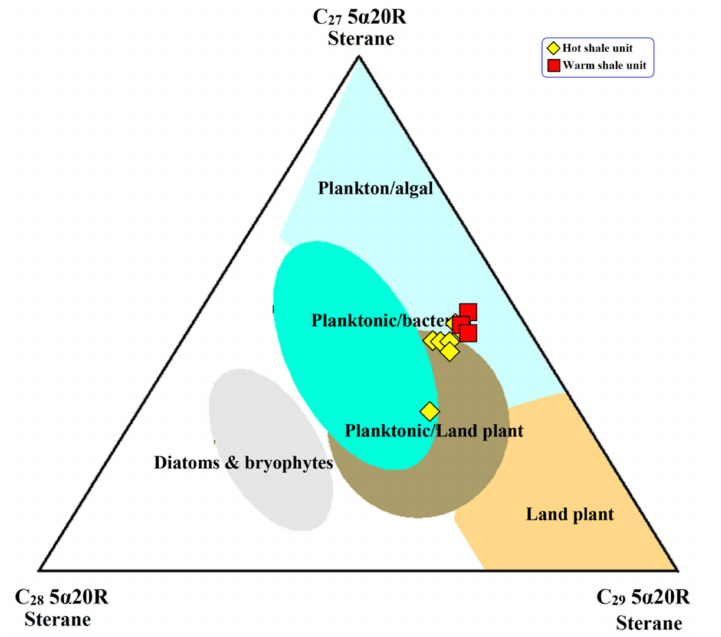
Figure 12. Ternary diagram of regular steranes (C27-C29) in the aliphatic hydrocarbon fraction in the analyzed shale samples, indicating the relationship between sterane compositions, concerning organic matter input (modified after [43]).